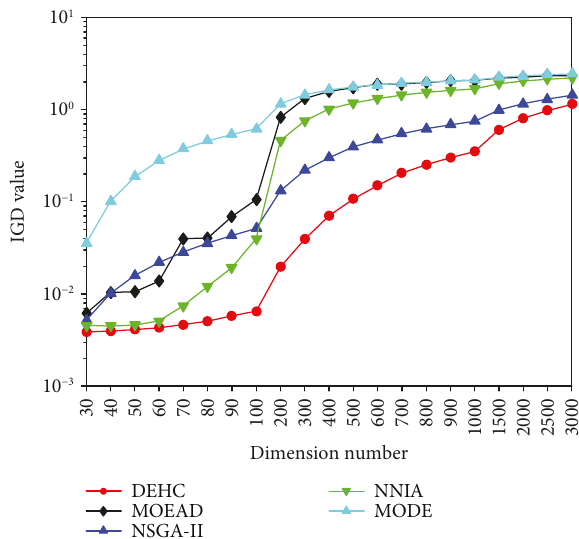
Figure 10: Mean IGD on ZDT1 as the number of decision variable